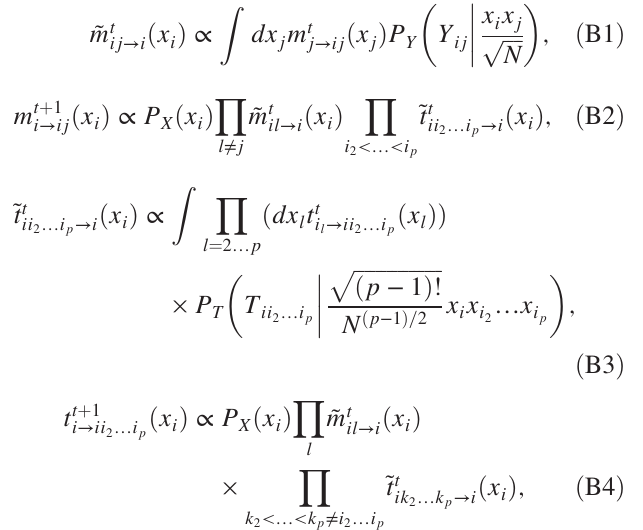
FIG. 6. The factor graph representation of the posterior measure of the matrix-tensor factorization model. The variable nodes represented with white circles are the components of the signal, while black squares are factor nodes that denote interactions between the variable nodes that appear in the interaction terms of the Boltzmann distribution in Eqs. (A6) and (A7). There are three types of factor nodes: P is the prior that depends on a single variable, P is the probability of observing a matrix element Y given the values of the X Y ij variables x and x , and, finally, P is the probability of observing a tensor element T . The posterior, apart from the normalization i j T i 1 ; … ;i p factor, is simply given by the product of all the factor